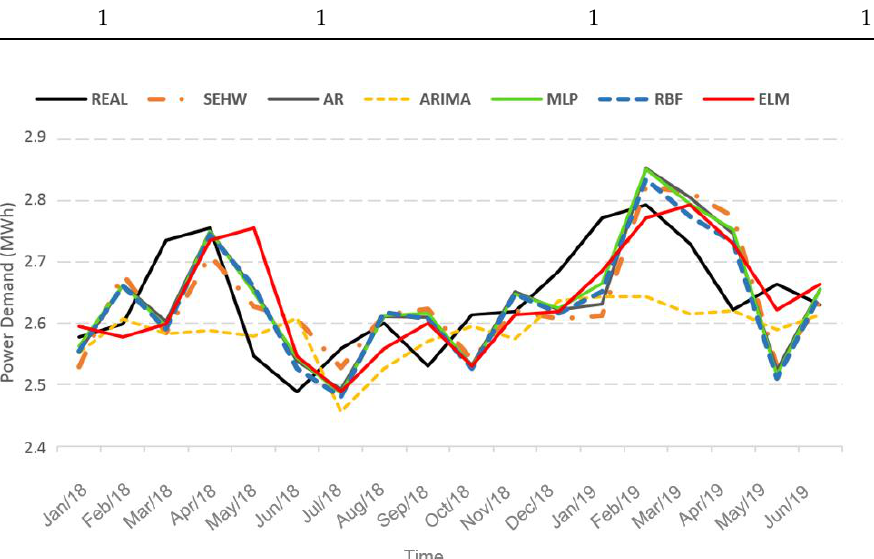
Figure 6. Graph comparing actual data with data predicted for six steps ahead, using HW, AR, ARIMA, MLP, RBF, and ELM models.